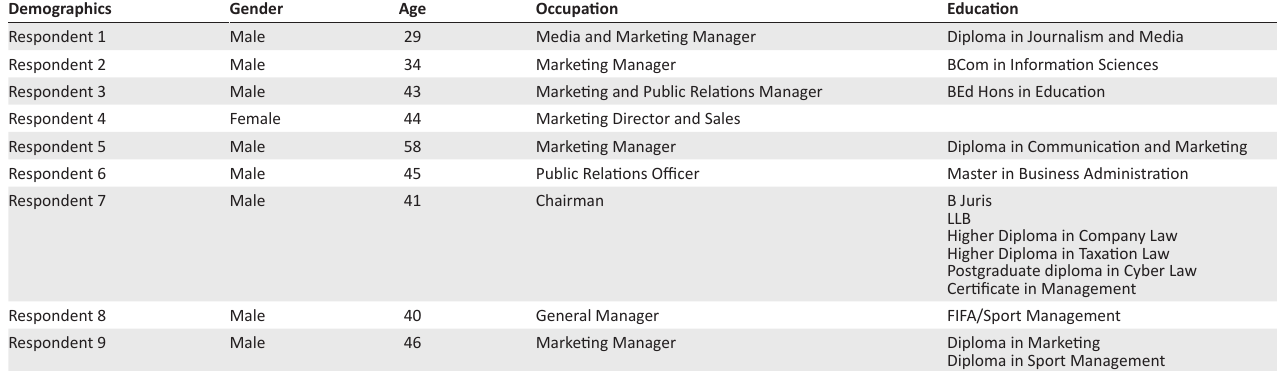
TABLE 1: The demographic characteristics of the club managers.